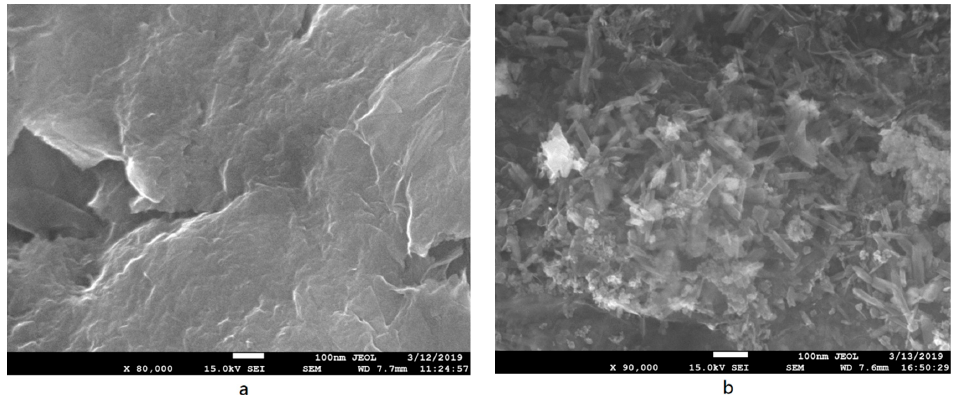
Figure 4. SEM micrographs of GO ( a ) and ATP/Fe 3 O 4 /GO ( b ).